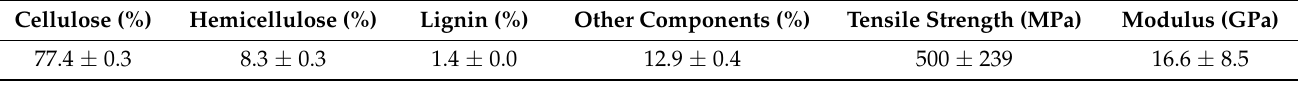
Table 1. The properties of hemp fiber used in this study.